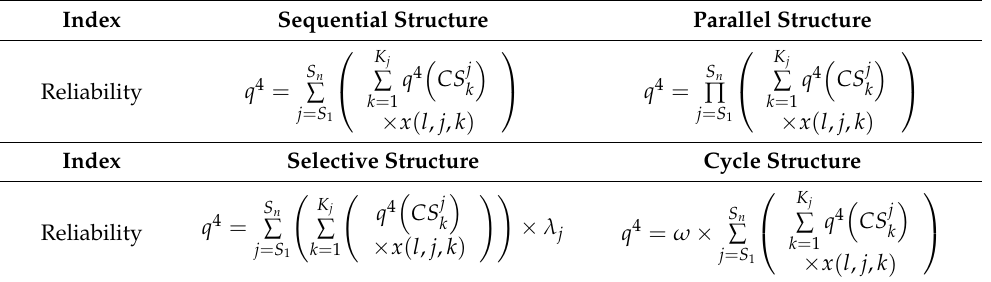
Table 10. QoS expressions of internal composite